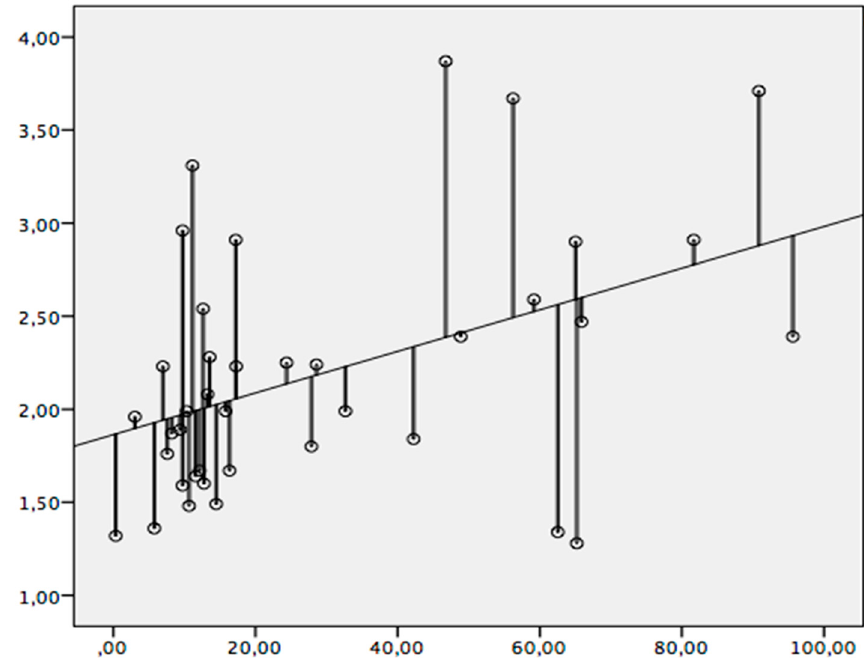
Figure 3. Significant correlation between TBD and finger grip strength deficit percentage when performing a one finger crimp. X axis: the percentage of force deficit of the injured finger measured with a Bindar in Newtons. Y axis: the TBD of the injured finger measured in the longitudinal axis in millimeters.